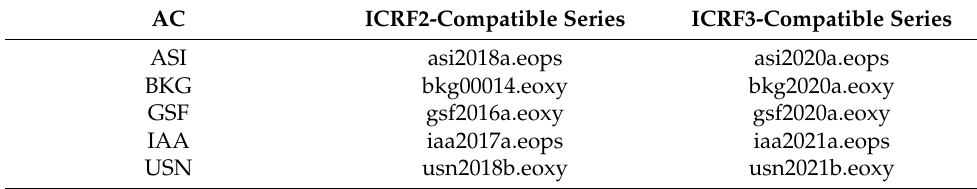
Table 2. List of VLBI global solutions considered in Test A 1 .